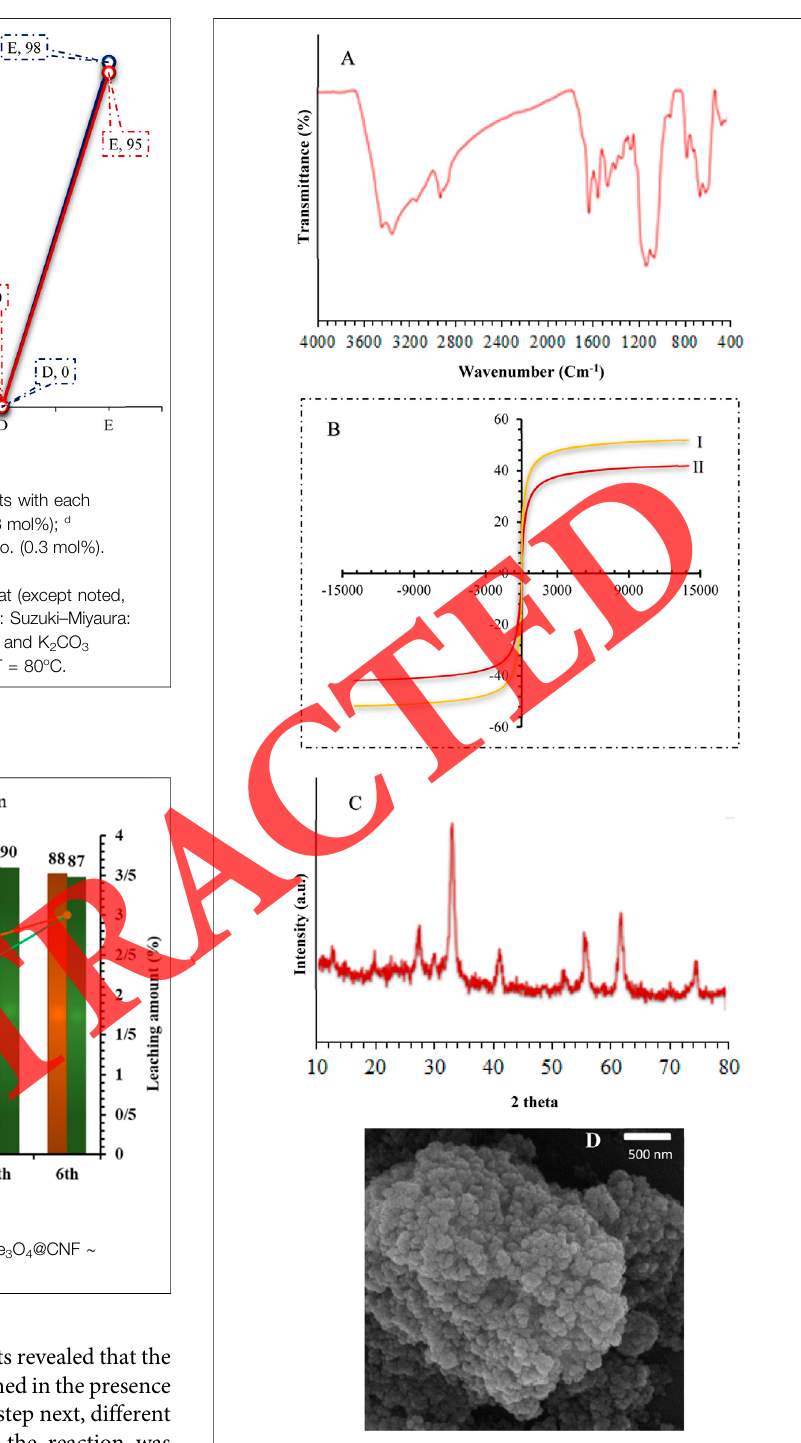
FIGURE 13 | (A) Fourier-transform infrared, (B) vibrating-sample magnetometry curves (I (cid:1) beforeruse and II (cid:1) after reuse), (C) X-ray diffraction spectra, and (D) FE-SEM for fresh (green) catalyst after six recovery steps for the Hiyama reaction.